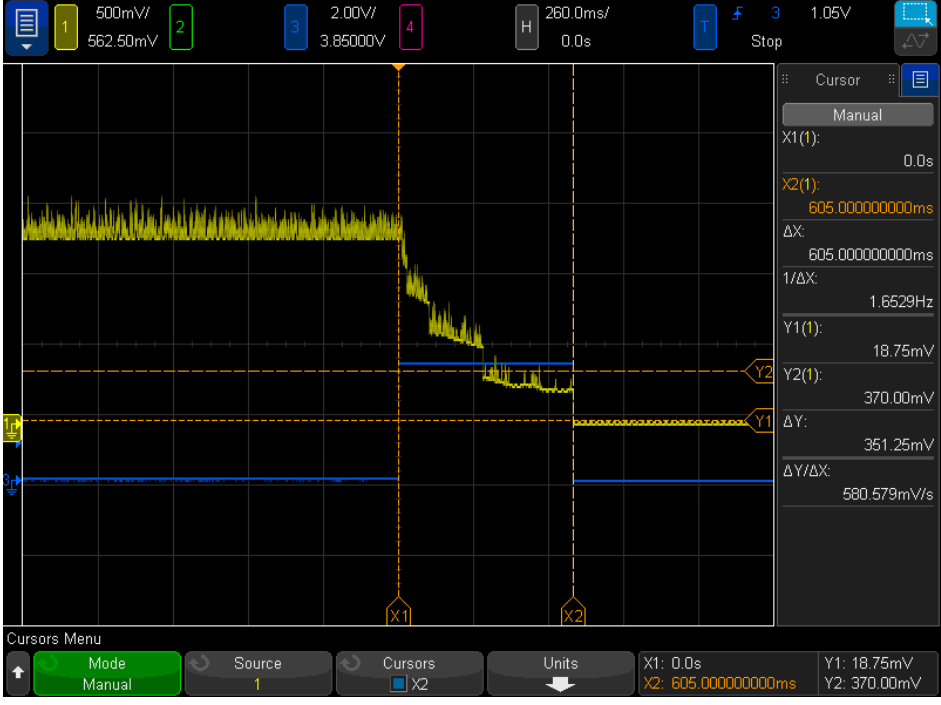
Figure 8. Detection and disconnection of 72 advertisers.